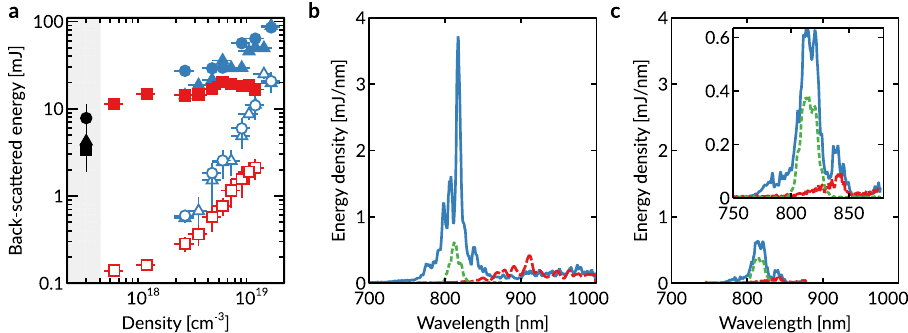
Fig. 1 Main experimental results. a Back-scattered energy in the seed direction. Combined pump and seed shots are depicted by solid symbols, circle and triangle for positive frequency chirp, and square for negative frequency chirp. Empty symbols represent corresponding shots without the seed pulse i.e. scattering from noise. The different symbol shapes characterise different runs. The energy values are averages of three shots, with the error given as the standard deviation. Error on the inferred plasma density is estimated to be ±20%. Where the error bars are not visible, their lengths are smaller or equal to the symbol sizes. b , c are single-shot spectra. Solid (blue) line: seed spectrum after interaction; dotted (green) line: initial seed spectrum; dashed (red) line: spectrum of pump back-scattered signal without seed. Areas under the curves have been normalised to the measured energy, assuming that little energy falls outside the spectral window. b Pump with a positive frequency chirp, plasma density ~1.5 × 10 19 cm − 3 ( n p / n c ≈ 8.6 × 10 − 3 ); c Pump with a negative was used compared to that in b . The inset in c displays the same data as c plotted on a magni fi ed